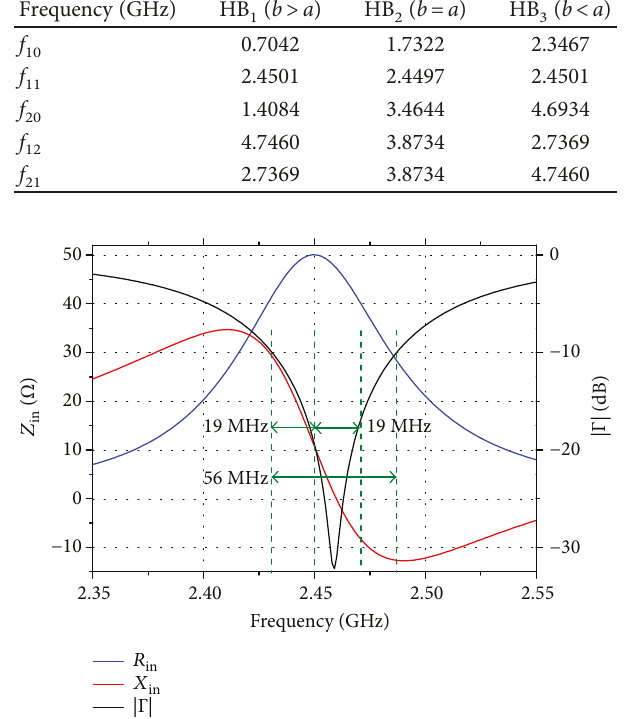
Figure 3: HB input impedance and re fl ection coe ffi cient module. 1